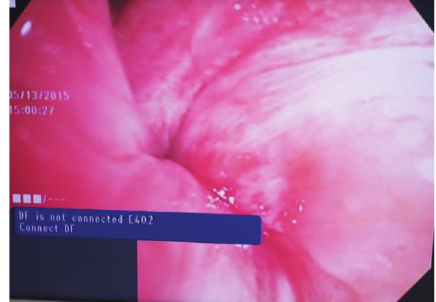
Figure 4: Flexible bronchoscopy showing tight left lower lobe